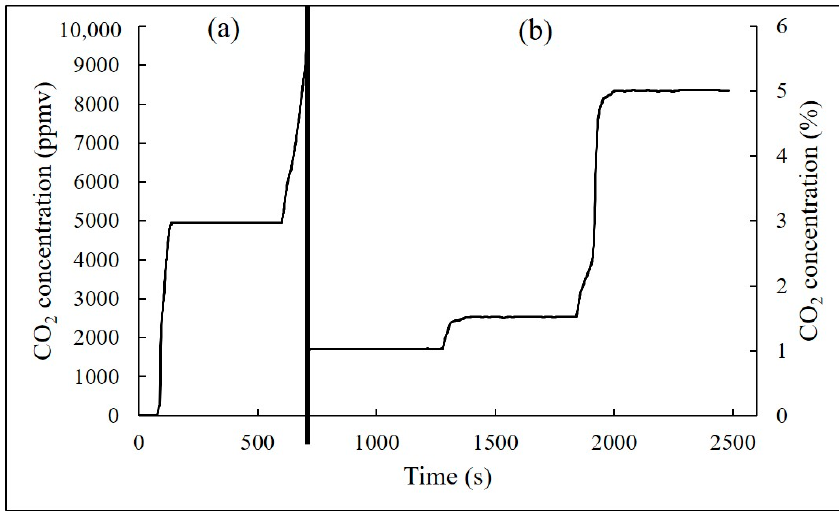
Figure 9. Variations of CO 2 concentrations observed from the analyzer with respect to various standard gas concentrations at the ppmv level ( a ) and at the percentage level ( b ).